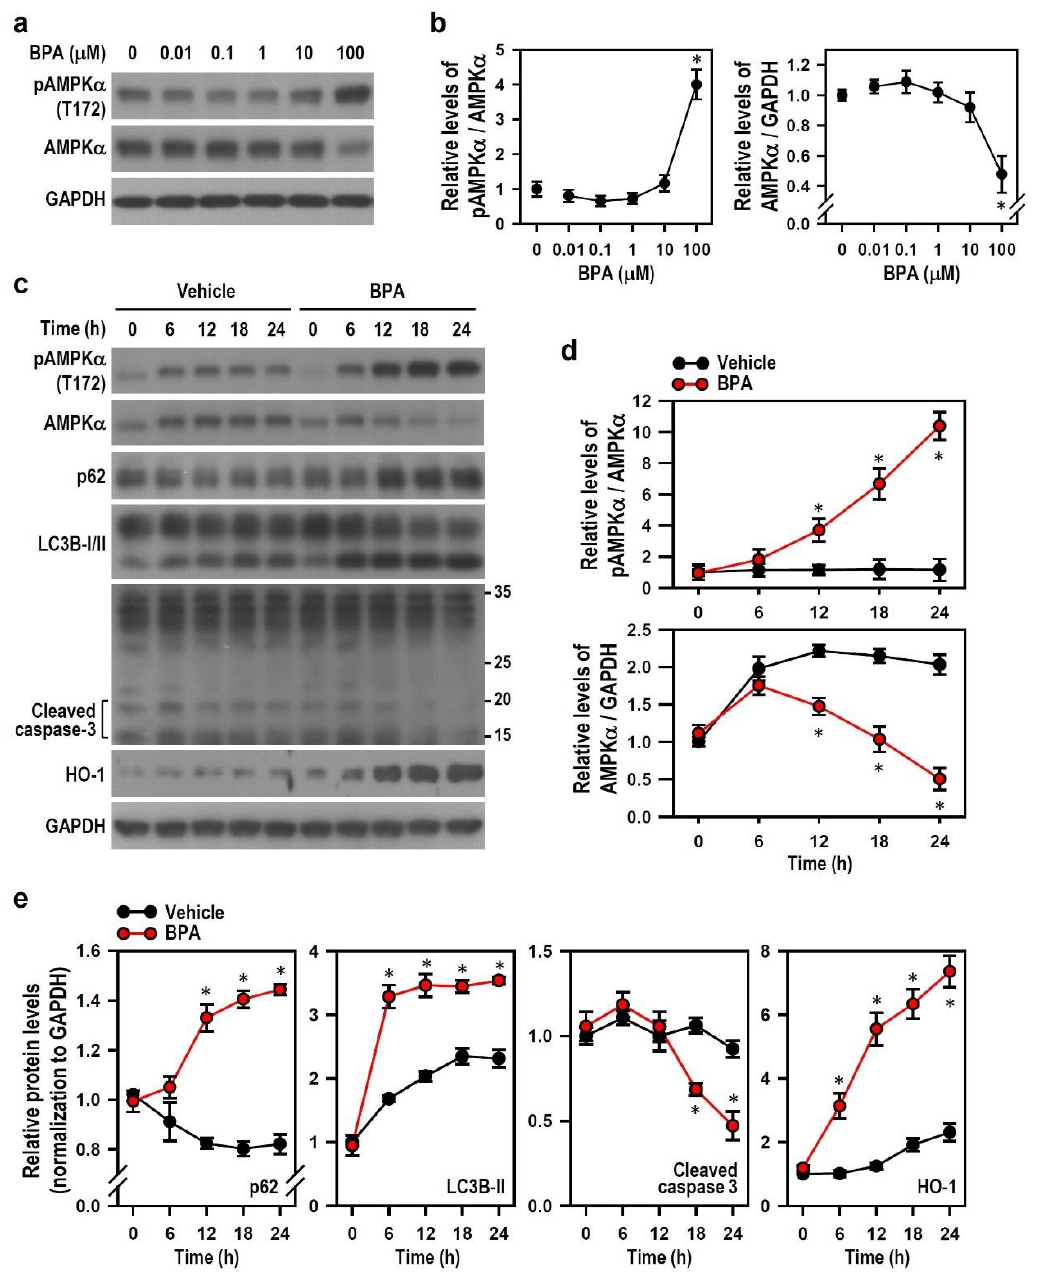
Figure 7. BPA enables activation of AMPK and time-dependently causes an AMPK α phosphorylation, accompanied by up-regulation of LC3B, p62, and HO-1 and down-regulation of cleaved caspase-3. ( a , b ) Cultures were treated with various BPA concentrations for 24 h. The levels of pAMPK α and AMPK α were detected by Western blots. The line plots show the quantitative data of pAMPK α (normalized by AMPK α ) and AMPK α (normalized by GAPDH) relative to the untreated control group (0 µ M BPA; assigned a value of 1). Each point represents the mean ± SEM ( n = 4). * p < 0.05 vs. control group. ( c – e ) Cultures were treated with vehicle or 100 µ M BPA for various time periods as indicated. The levels of pAMPK α , AMPK α , p62, LC3B, caspase-3, and HO-1 were detected by Western blots. The line plots show the relative quantitation values after normalization. The protein level at a time point of 0 h is assigned a value of 1. Data are represented as mean ± SEM ( n = 4). * p < 0.05 vs. vehicle group at identical time point.